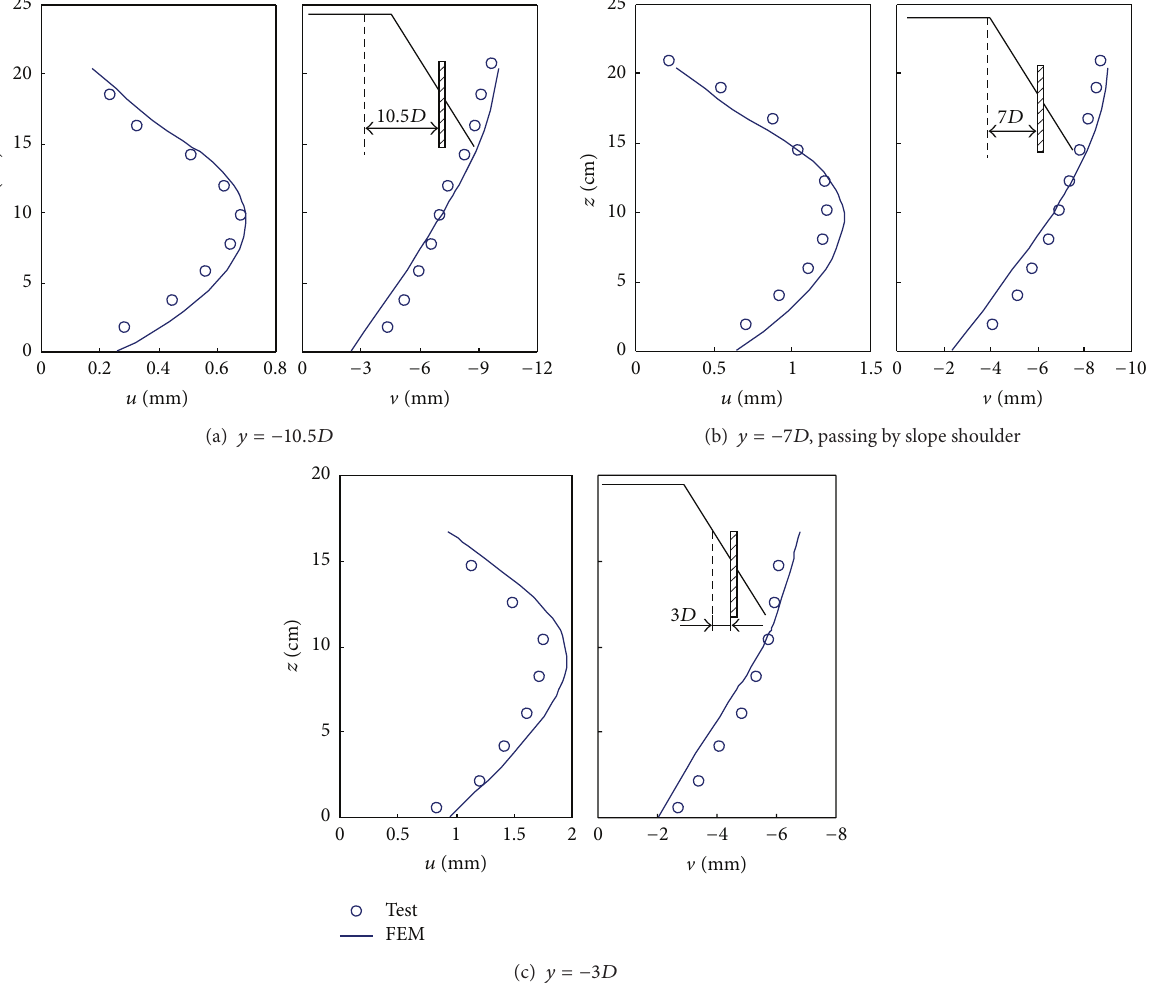
Figure 5: Displacement distribution comparison of numerical analysis and test results on different vertical sections. u : horizontal displace- ment; v : vertical displacement; D : pile diameter.